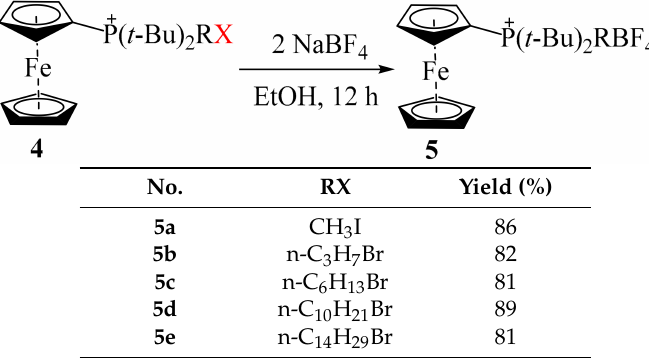
Table 4. Reaction of substitution of anions in Fc-containing phosphonium salts.